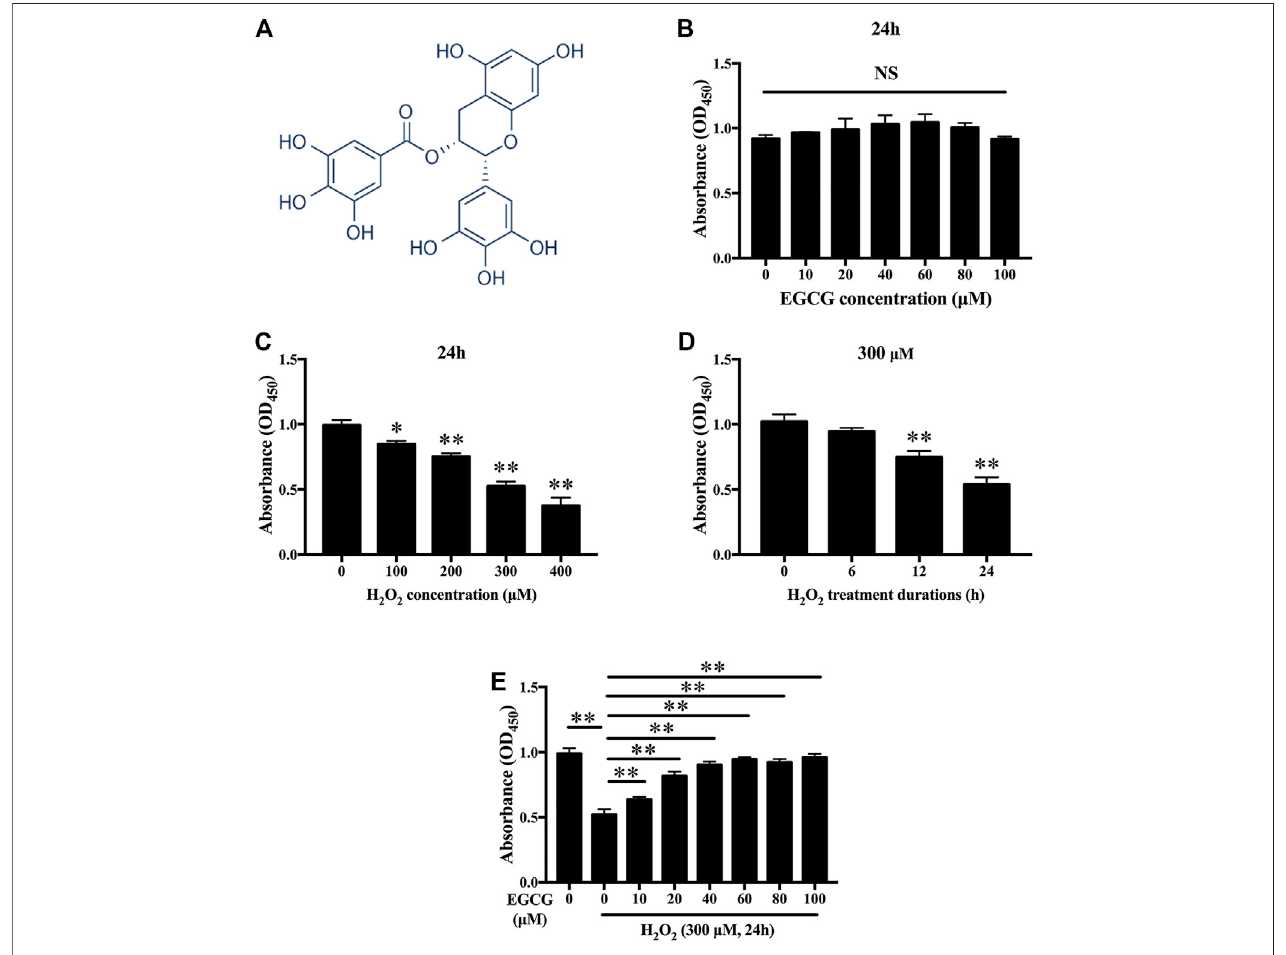
FIGURE 1 | Effects of EGCG as well as H 2 O 2 on NPCs viability. (A) Chemical structure of EGCG. (B) Findings from CCK-8 indicating NPCs viability after treatment withvariousconcentrationsofEGCGand (C) H 2 O 2 for24 h. (D) CellviabilitiesofNPCsafter300 μ MH 2 O 2 treatmentatvarioustimes(0,6,12,aswellas24 h). (E) CCK-8 fi ndings indicating NPCs viability after treatment with 300 µM H ± SD ( n (cid:2) 3). * p < 0.05, 2 O 2 and different concentrations of EGCG for 24 h. Data are shown as mean ** p <